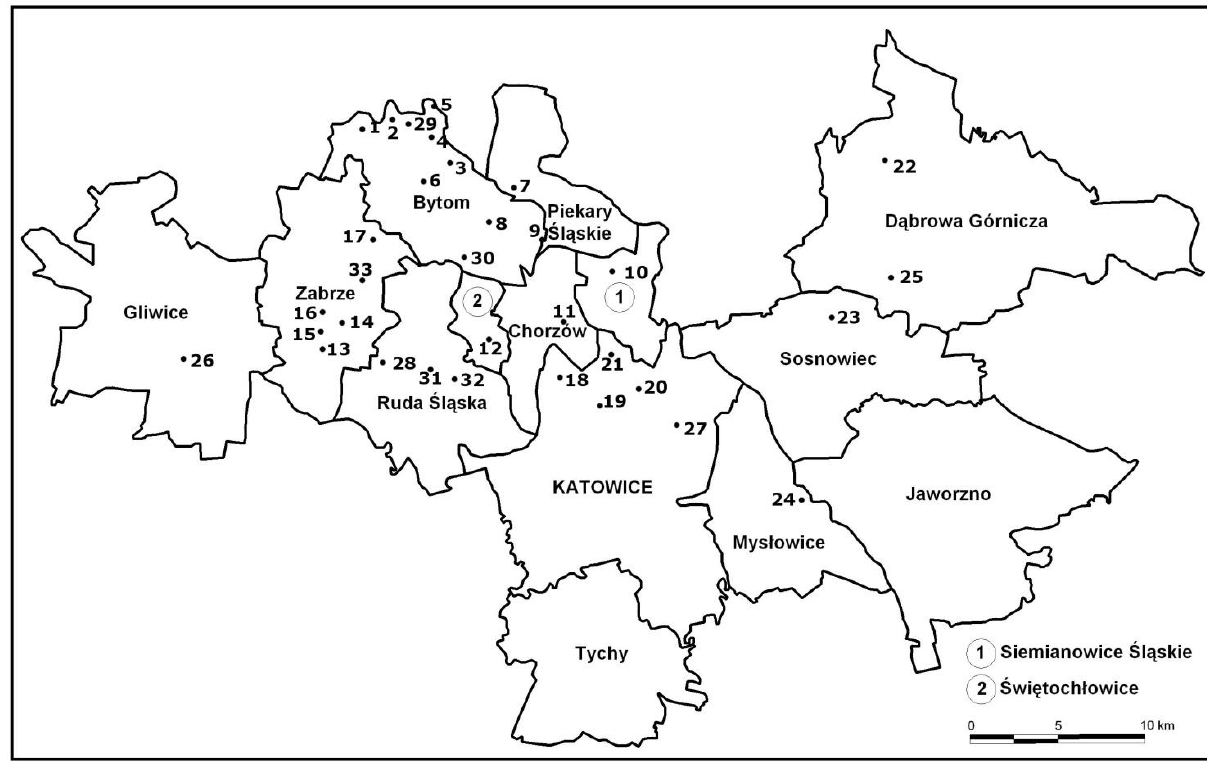
Fig. 1. Location of post-industrial cultural sites in the Katowice conurbation (after Lamparska-Stobiecka,